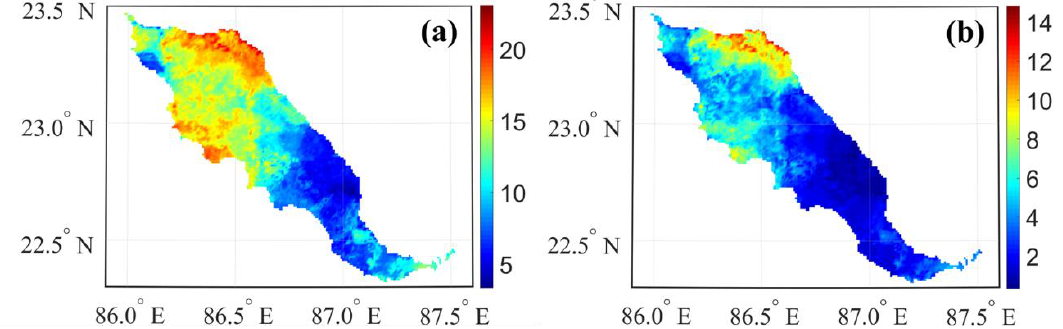
Figure 15. Grid-averaged scPDSI values from 1985 to 2014 for study area BK based on historic observed data. Forecasting 2020 , 2 FOR PEER REVIEW